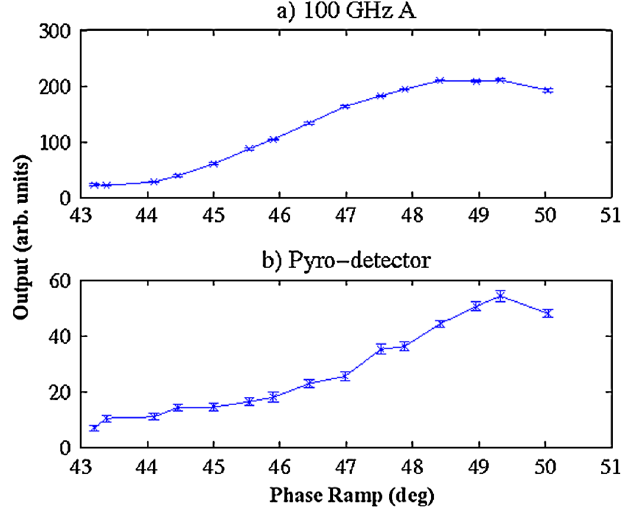
FIG. 8. (Color) Normalized output of (a) the 100 GHz diode and (b) the pyroelectric detector for a range of linac phase settings. Note that the phase ramp figures are quite different from those shown in Fig. 4 due to changes in the calibration of the linac phase measurement system.